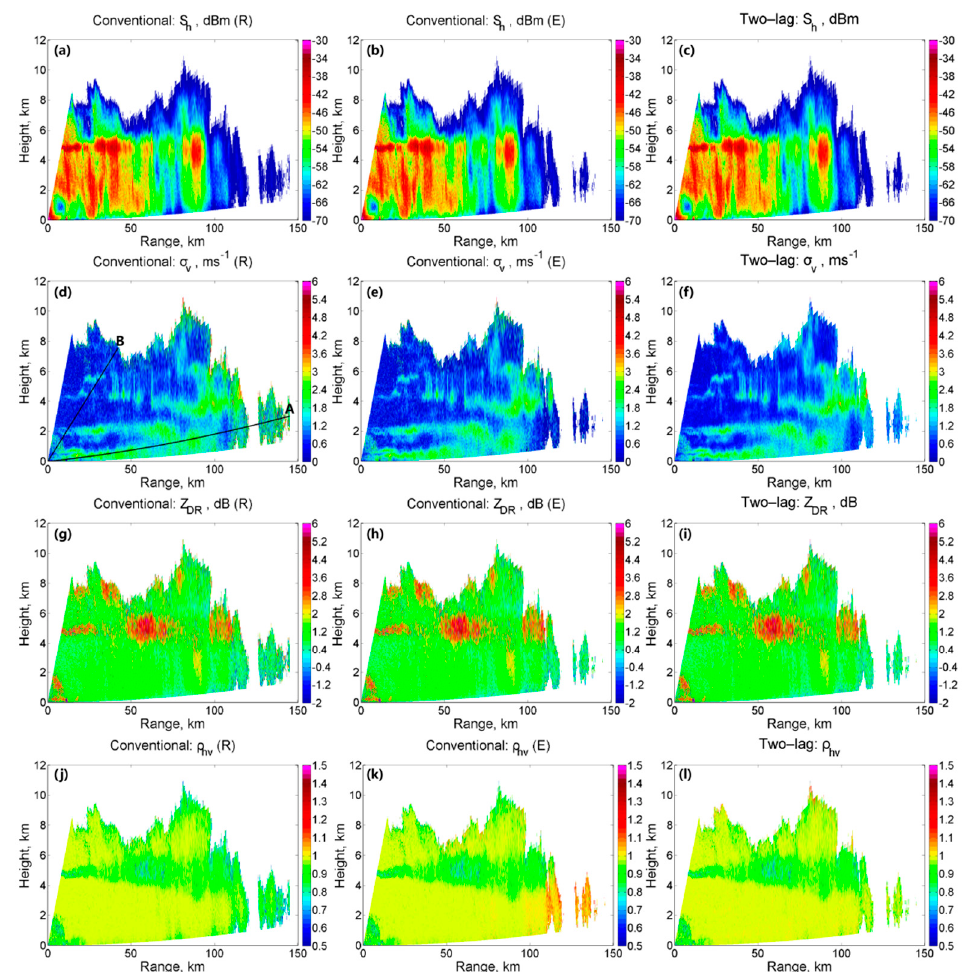
Figure 2. Comparison of conventional estimators (left and middle column) and two-lag estimators (right column). Four rows show S h , σ v , Z DR, and ρ hv , respectively. Letter R in brackets means that